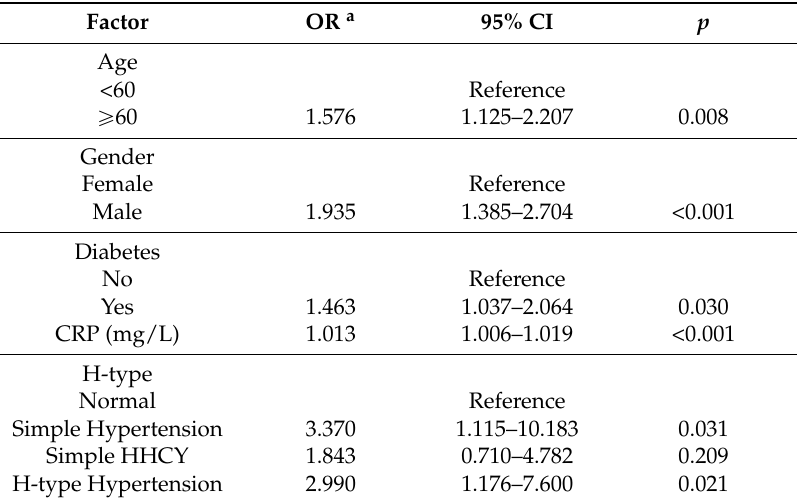
Table 3. Multivariate logistic regression analysis of factors related to RIS. Factor OR